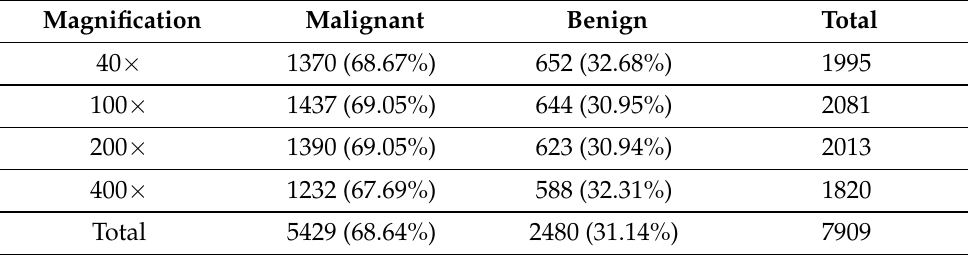
Table 2. Distribution of the histopathological breast cancer images in the BreakHis dataset by amplication factor and